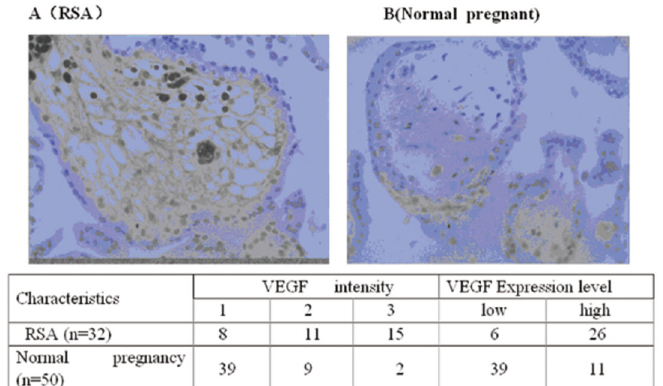
Figure 3. Immunohistochemistry for VEGF protein expression in chorionic villus. VEGF protein was expressed in the chorionic villus located in the cytoplasm (Original magnification ×600. VEGF intensity by immunohistochemistry staining was scored